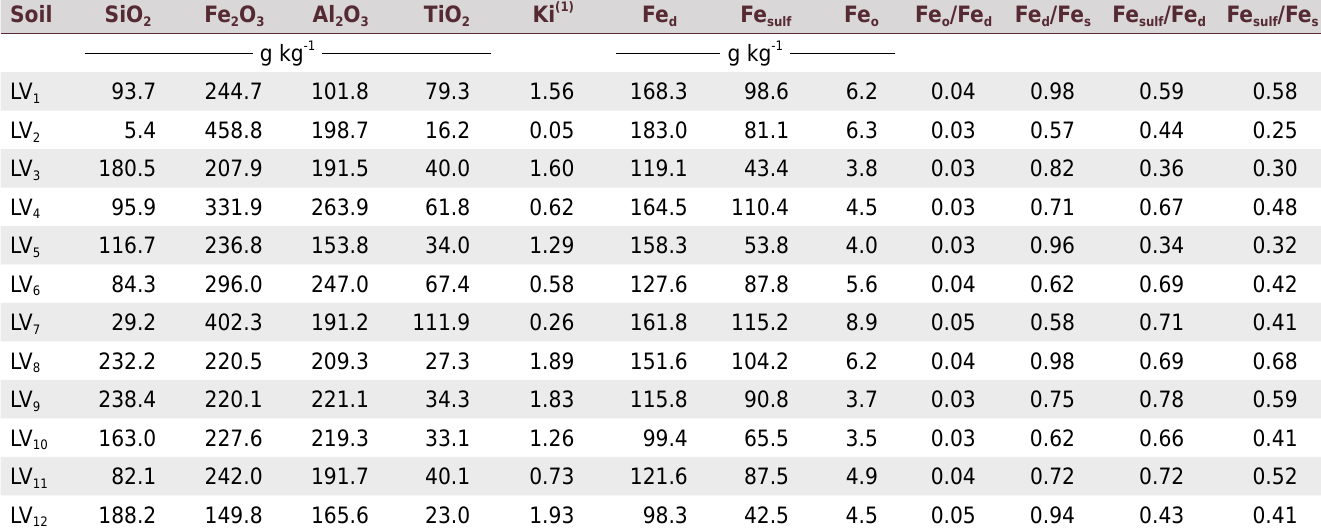
Table 6. Contents of Si s , Fe s , Al s , and Ti s extracted by sulfuric digestion (expressed in oxides), Ki index, and Fe obtained in the clay fraction by sequential extractions with Na-citrate-bicarbonate-dithionite (Fe d ), H 2 SO 4 1.8 mol L -1 (Fe sulf ), and only one extraction with acid oxalate ammonium (Fe o )